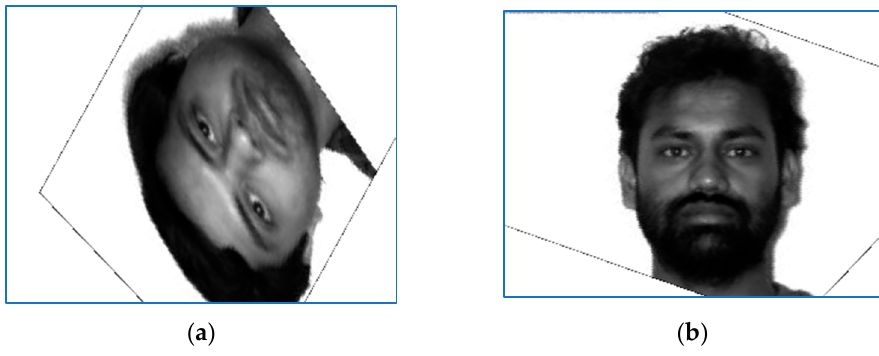
Figure 7. Images registered by RS-GD: ( a ) subject 10; ( b ) subject 7.